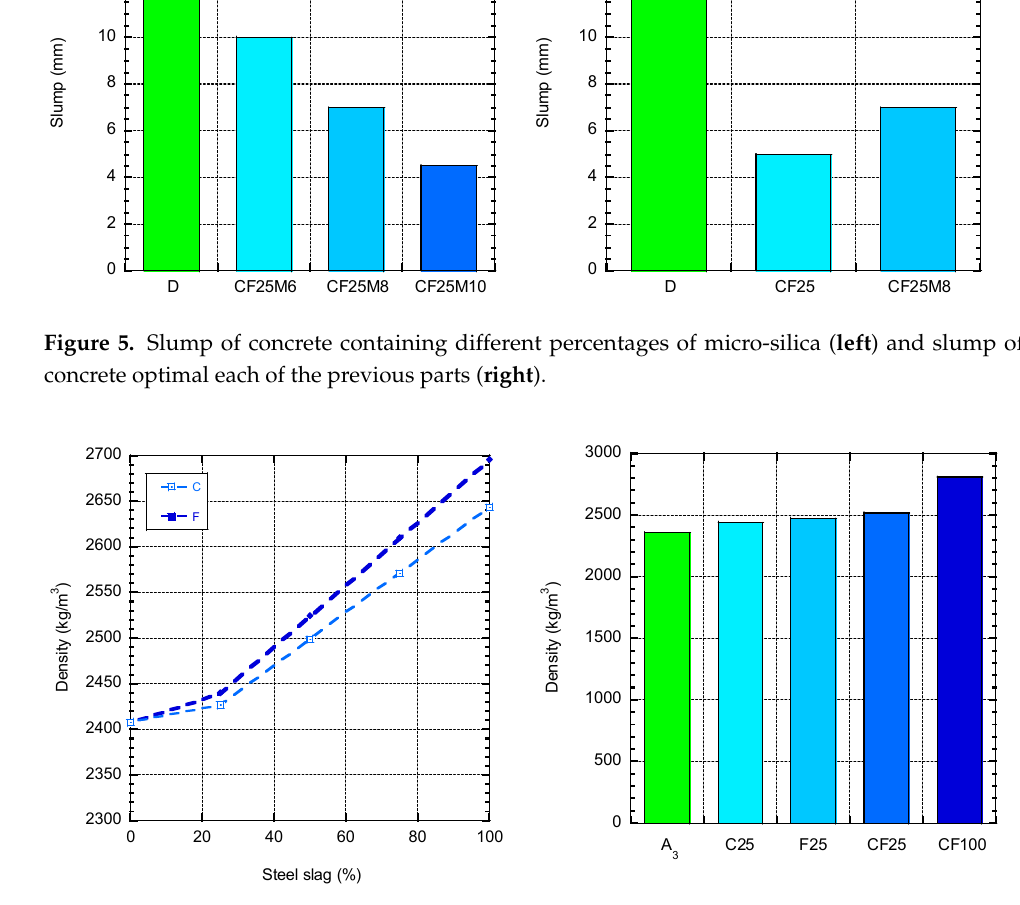
Figure 6. Density of concrete containing different percentages of EAFS ( left ) and density of concrete containing 25% of slag ( right ).